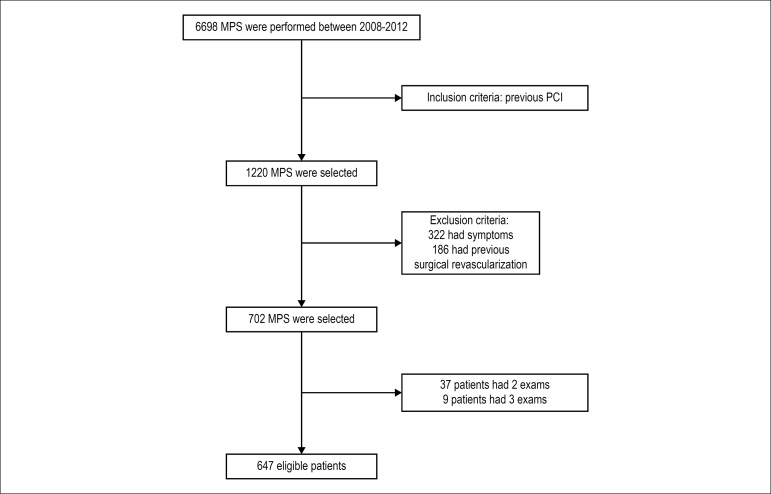
Flow chart of patient selection. PCI: percutaneous coronary
intervention; MPS: myocardial perfusion scintigraphy.